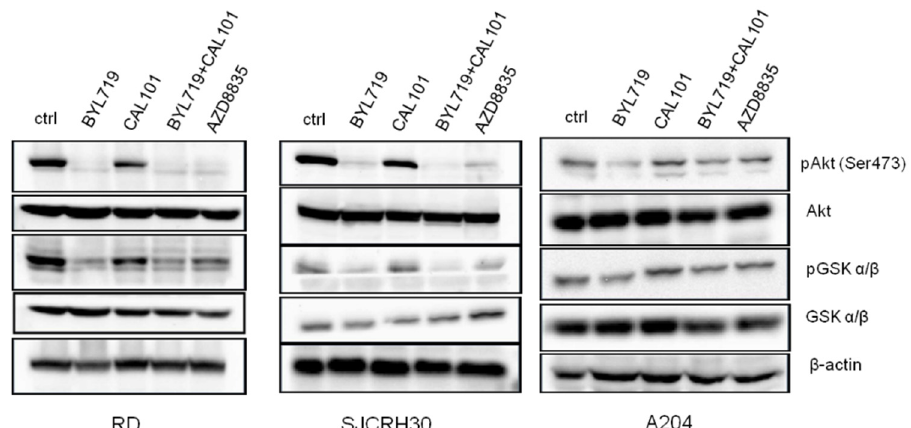
Figure 5. PI3K p110 α inhibitors down-modulate Akt signaling. RD, SJCRH30, and A204 cells were seeded at a concentration of 3 × 10 6 cells in T75 flasks; after an overnight incubation, cells were treated with 5 μ M of either BYL-719, CAL101 or BYL-719 + CAL101 (2.5 μ M + 2.5 μ M), or left untreated, for 24 h. Cells were collected, lysed and protein lysates were subjected to